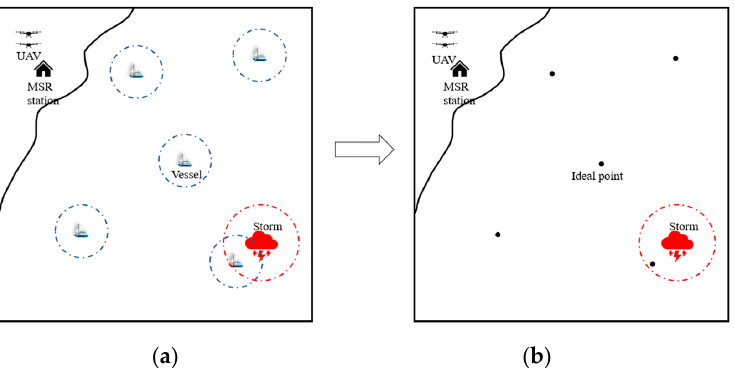
Figure 6. The scenes of the original and simplified MSR tasks. ( a ) The scene of the original MSR task. ( b ) The scene of the simplified MSR task.